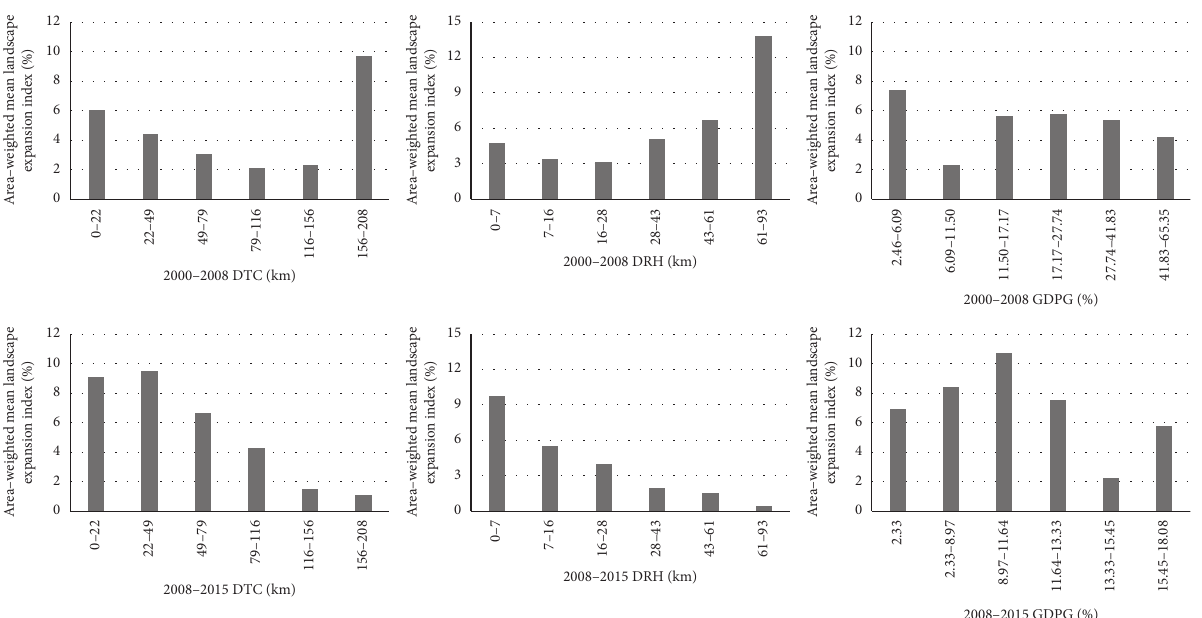
Figure 6: Risk analysis of DTC, DRH, and GDPG on urban expansion landscape pattern during 2000–2008 and